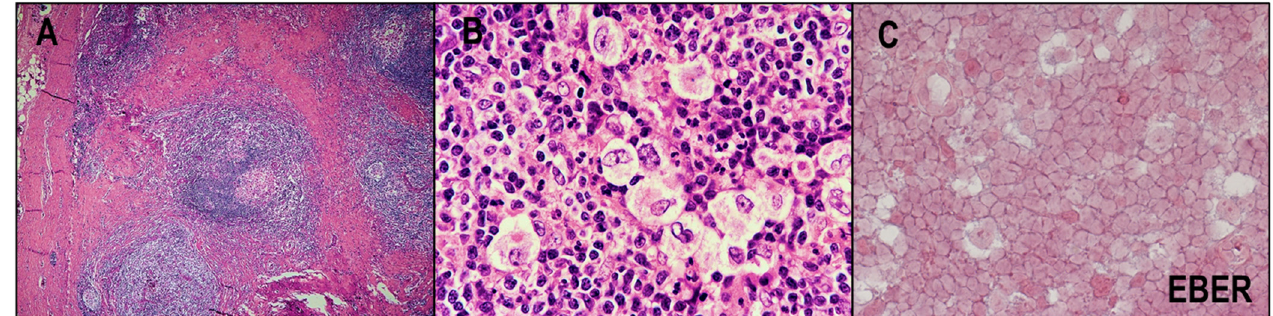
Figure 2. Nodular sclerosing classic Hodgkin lymphoma (NSCHL). ( A ) NSCHL is characterized